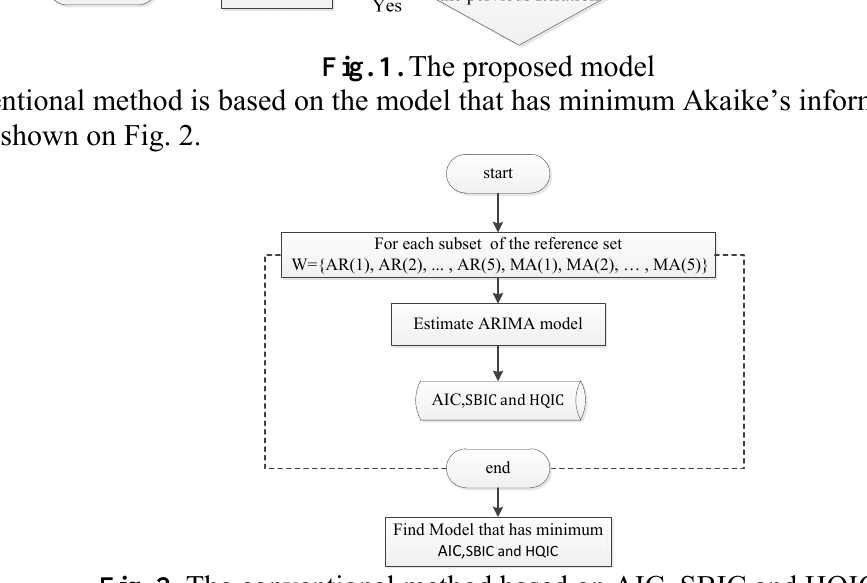
Fig. 2. The conventional method based on AIC, SBIC and HQIC